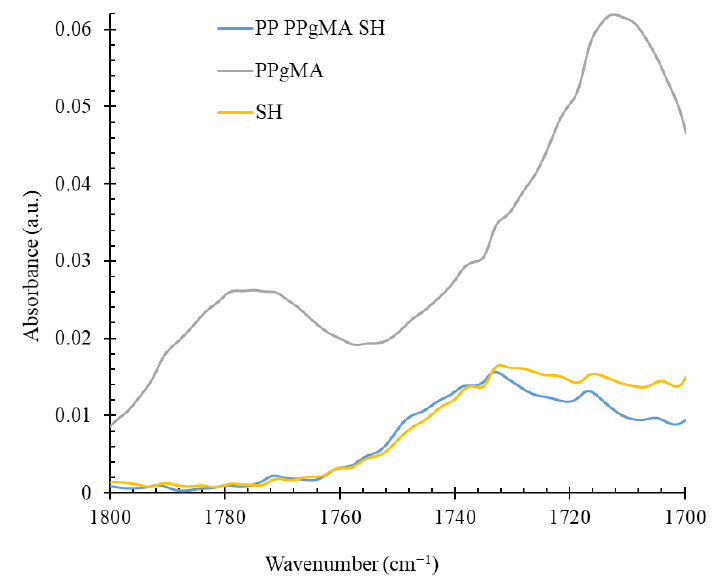
Figure 4. FTIR spectra of SH, PPgMA, and PPSH composite.